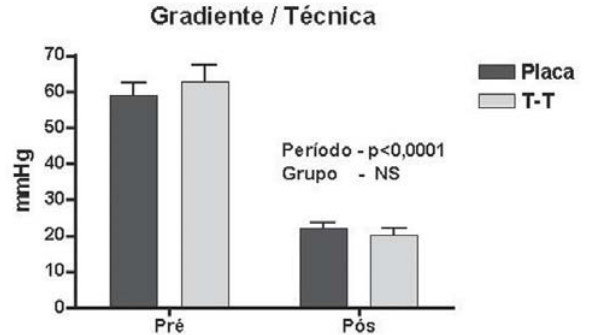
Fig. 3 - Gradientes pré e pós-operatórios, de acordo com a técnica operatória empregada. T/T = término terminal; mmHg = milímetros de mercúrio